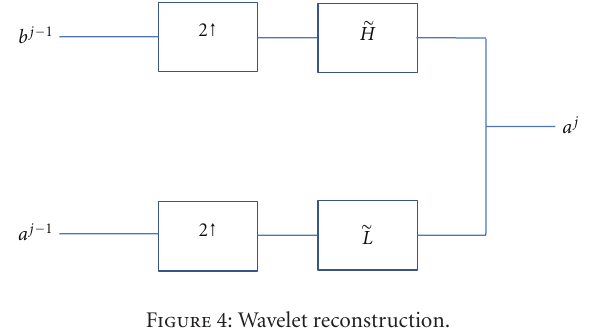
Figure 4: Wavelet reconstruction.